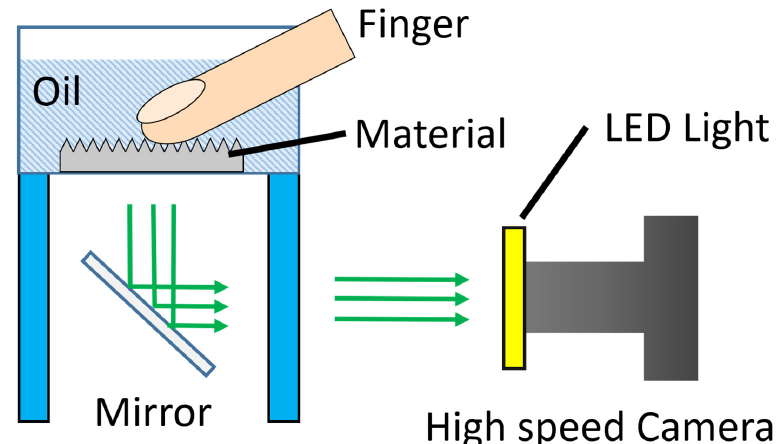
Figure 4. View of the measurement system taken from the side. To verify the principle of the system, we implemented a measurement system using Lego blocks. The texture is made optically transparent by filling an aquarium with a silicone oil having the same refractive index as the texture.